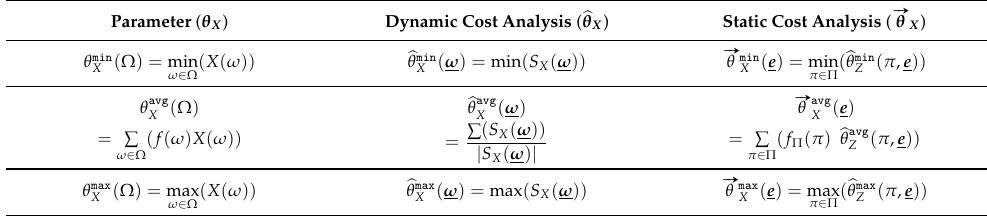
Table 2. Comparison of dynamic and static cost estimators.